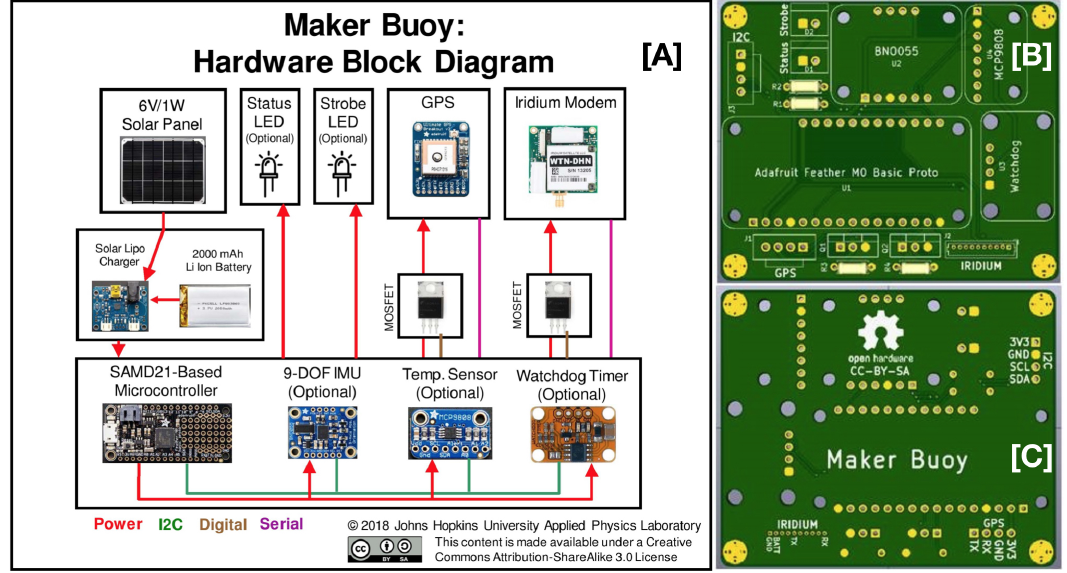
Figure 1. ( A ) A block diagram that shows the primary electronic components used in the Maker Buoy. ( B ) The front of the Maker Buoy PCB. ( C ) The back of the Maker Buoy